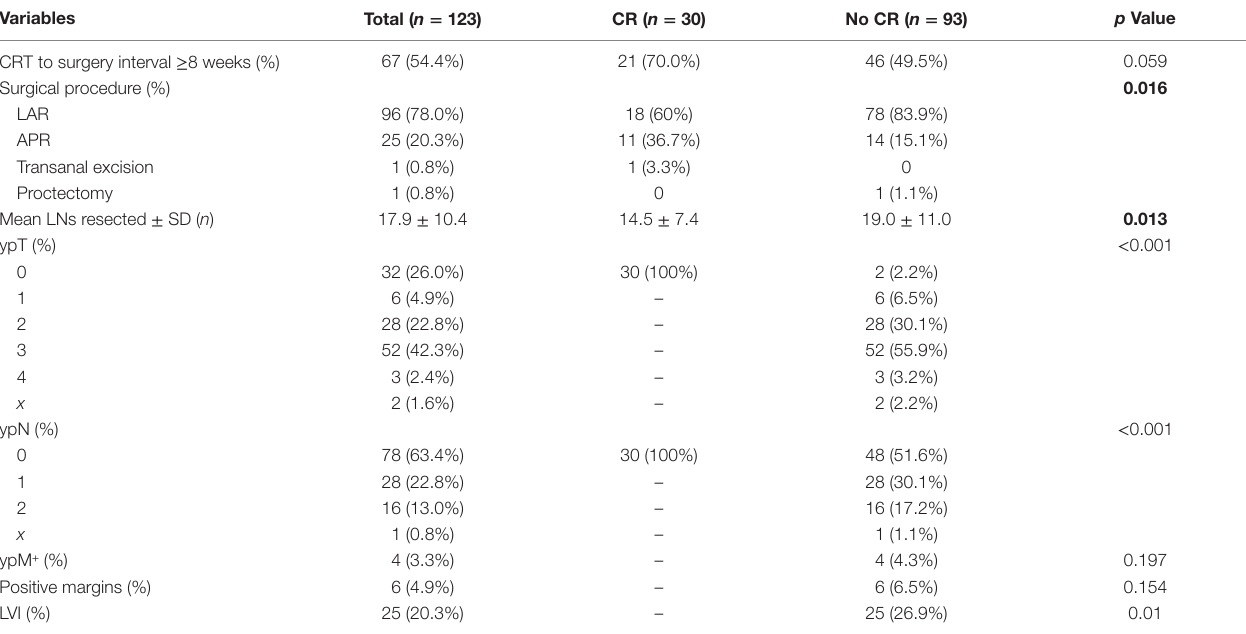
TaBle 3 | characteristics of surgical